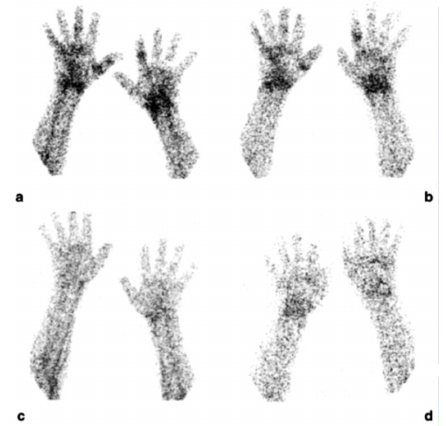
Figure 4. Scintigraphic images of wrists of a rheumatoid arthritis (RA) patient injected with ( 99m Tc)-adalimumab (anti-TNF α mAb) before ( a and b ; dorsal images after 6 and 20 h p.i., respectively) and 3 months after systemic therapy with adalimumab ( c and d ; dorsal images after 6 h and 20 h p.i., respectively), (from Malviya, G.; et al. Q. J. Nucl. Med. Mol. Imaging 2008 , 52 , 13–14)